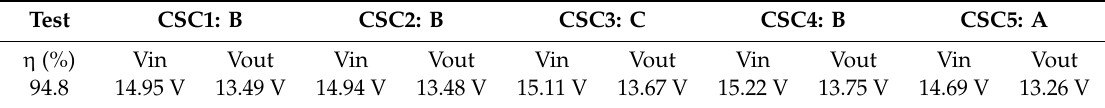
Table 7. PCA of 5 BBCBA CSCs configured in ISOS.